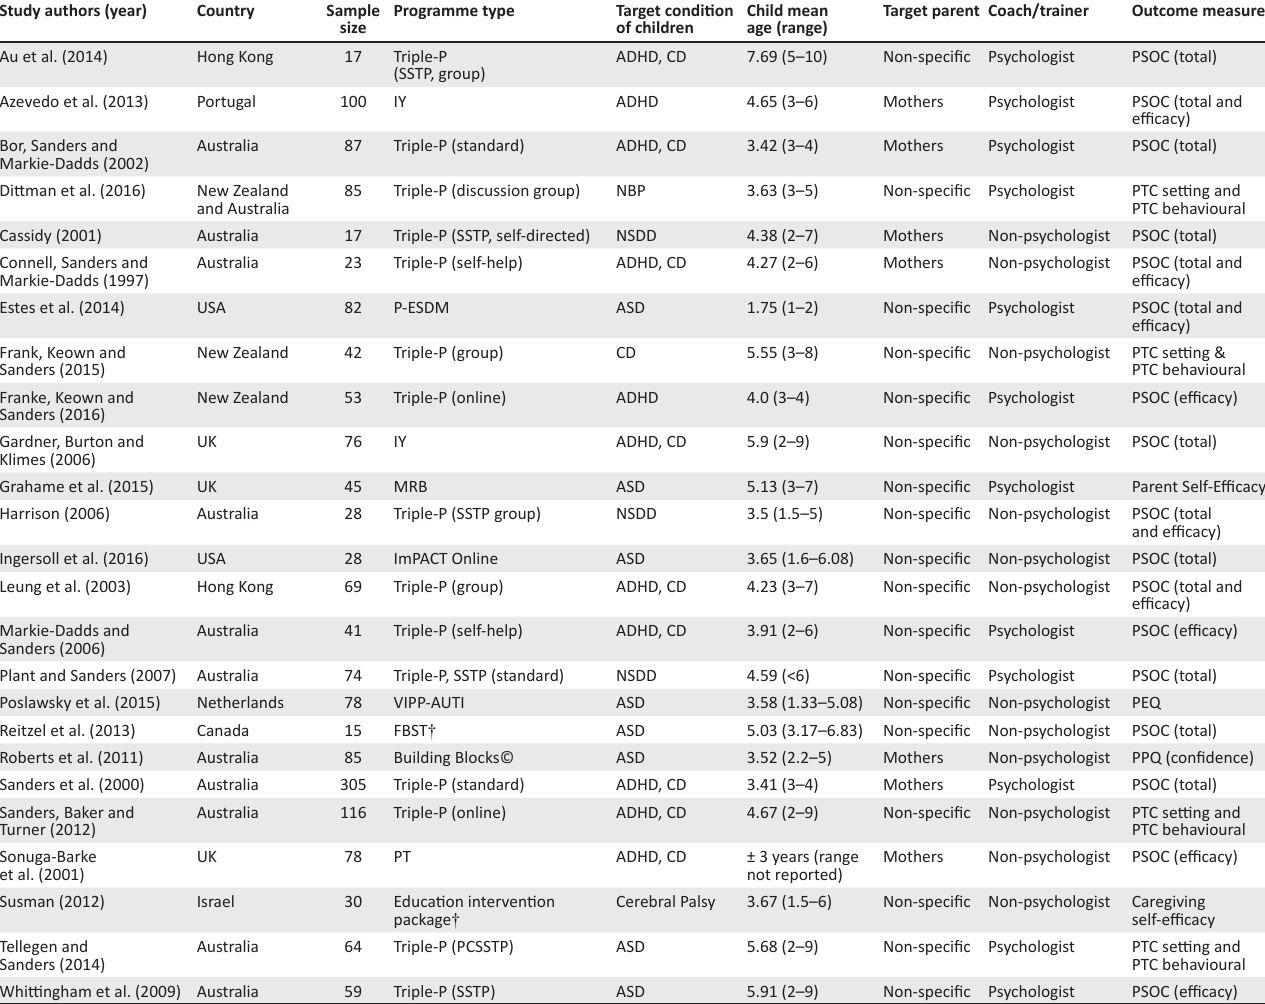
TABLE 1: Characteristics of randomised controlled trials conducted globally meeting inclusion